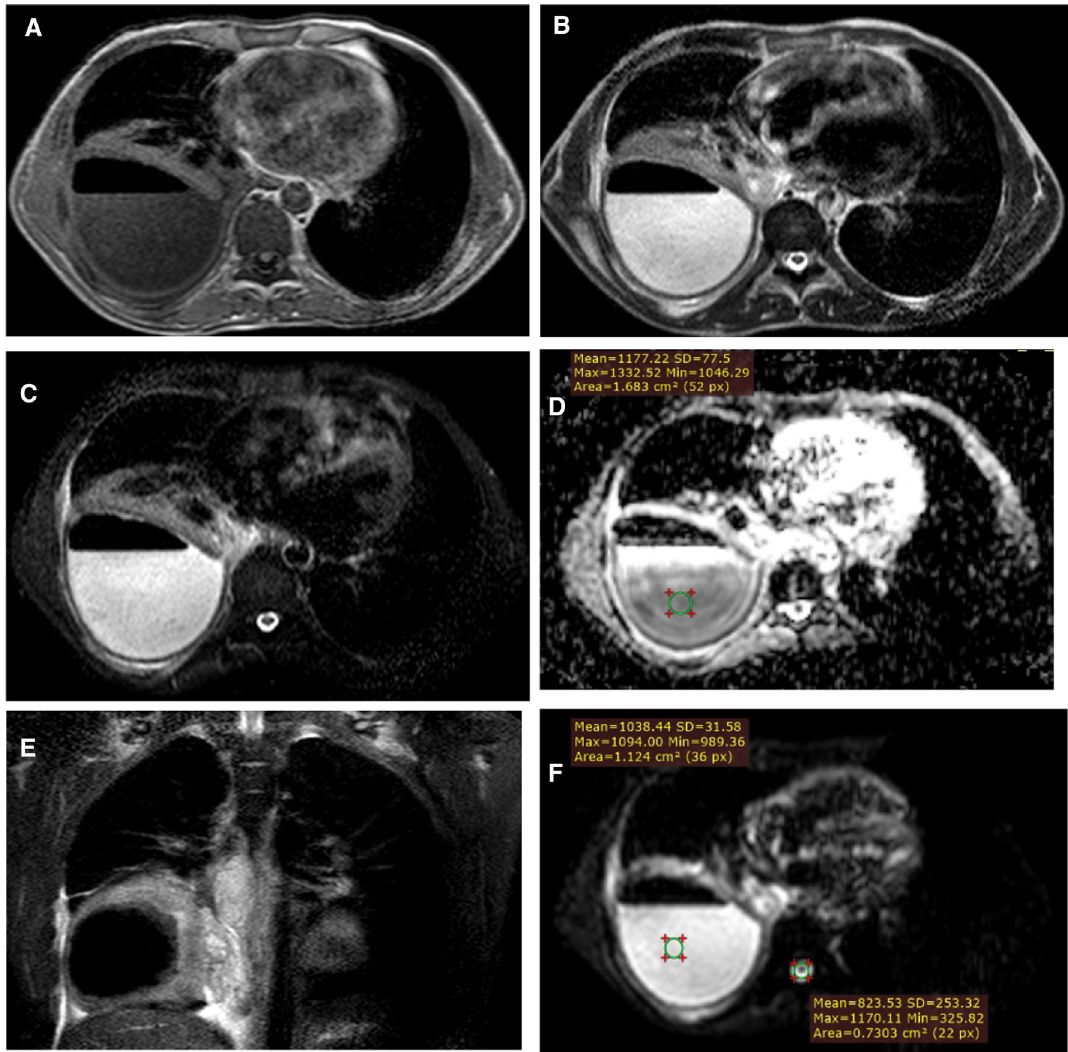
Axial T1 ( A ), axial T2 ( B ), axial STIR ( C ), coronalT2 ( D ) weighted MR images show right lower lobar well defined thick walled cystic lesion with air fluid level measuring 9.6 9.5x14 cm along its maximum axial and craniocaudal dimensions, respectively. It elicits hypointense signal and hyperintense × signal relative to the surrounding muscles on T1 and T2 respectively with surrounding lung consolidation. DWI ( E ) and ADC map ( F ) images